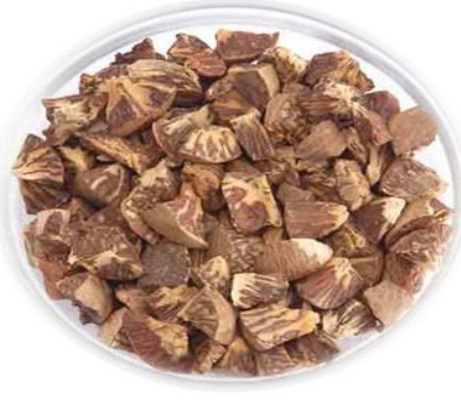
Figure 6. Ground nuts of Areca catechu